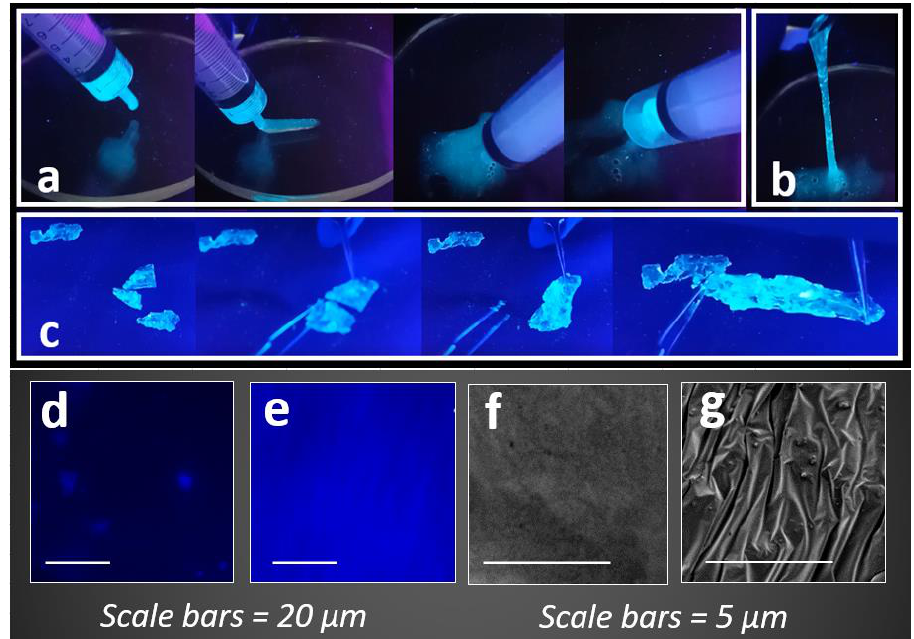
Figure 5. ( a ) The syringeability and ( b ) extensibility of the fluorescent PVA gel. ( c ) The self-healing property of the fluorescent PVA gel crosslinked with 100 mM borax solution. ( d , e ) Fluorescent mi- croscope and ( f , g ) SEM images were captured from the surface of PVA + AIE and PVA + nanoprobe,